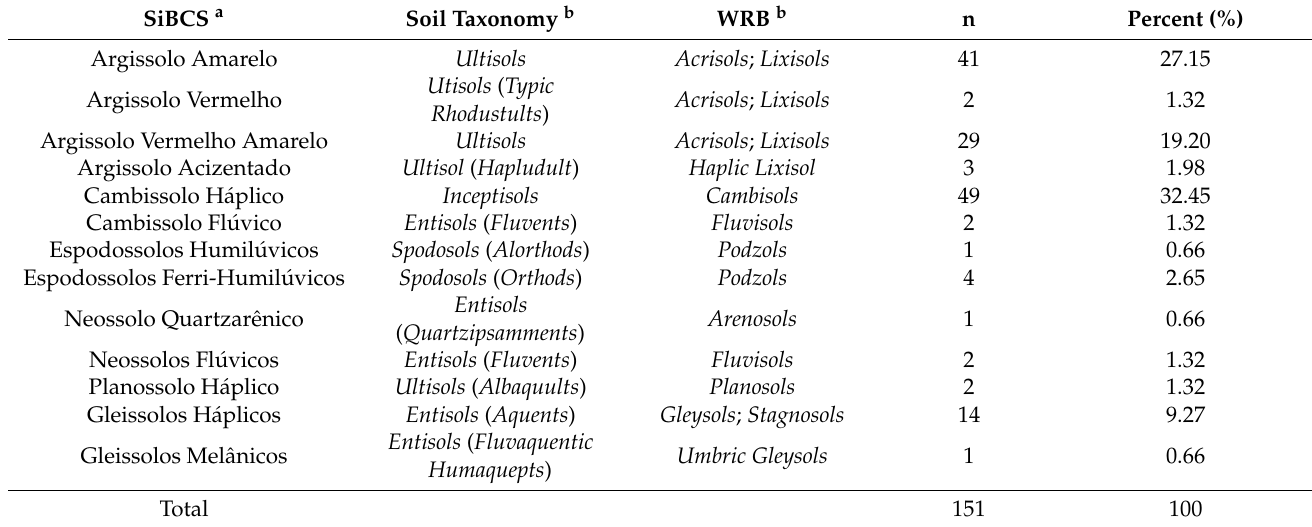
Table 1. Number (n) and percent of soil taxonomic classes in the 151 field